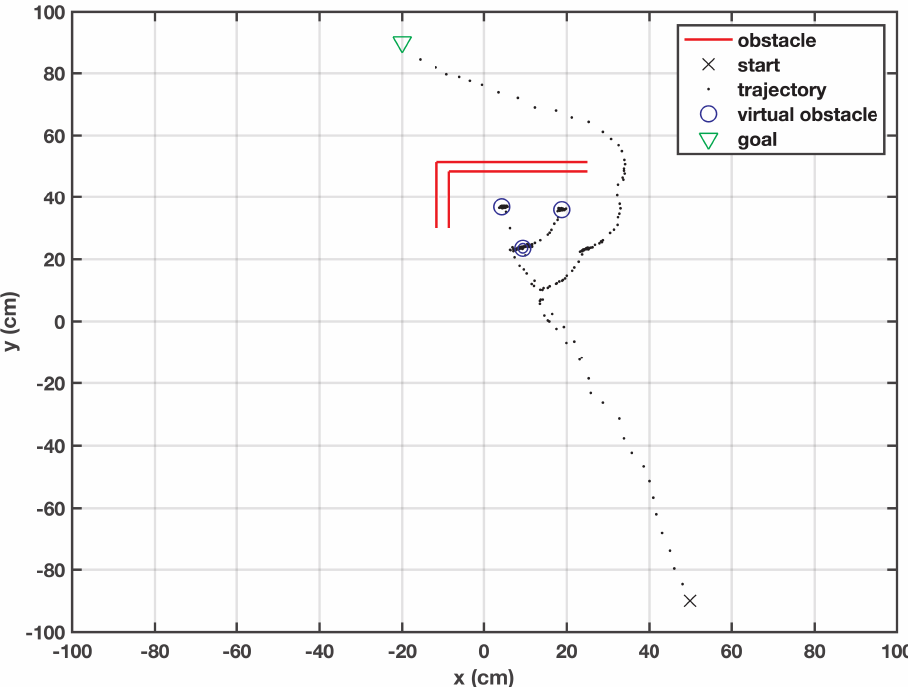
Figure 7. Behavior of the robot when L-shaped obstacle is encountered.